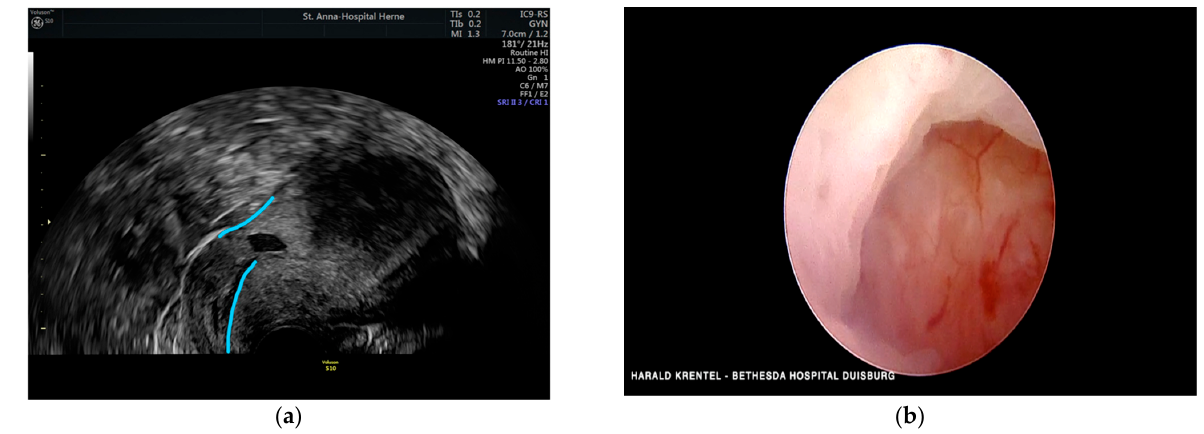
Figure 5. ( a ) Transvaginal ultrasound showing a uterine niche; ( b ) hysteroscopic view of uterine